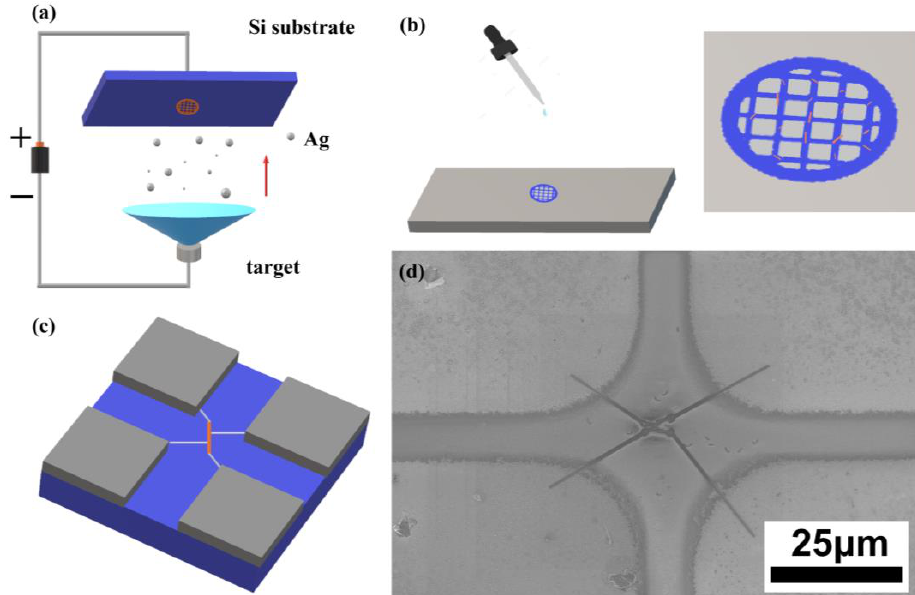
Figure 1. Schematic illustration for fabrication of the electrical measurements microdevice: ( a ) copper mesh was pasted on the cleaned substrate and a 200 nm layer of silver was deposited by e-beam evaporator; ( b ) nanowire solution was dripped onto the substrate with the pre-deposited Ag layer as a contact; ( c ) electrical measurement microdevice; ( d ) SEM image of the microdevice.